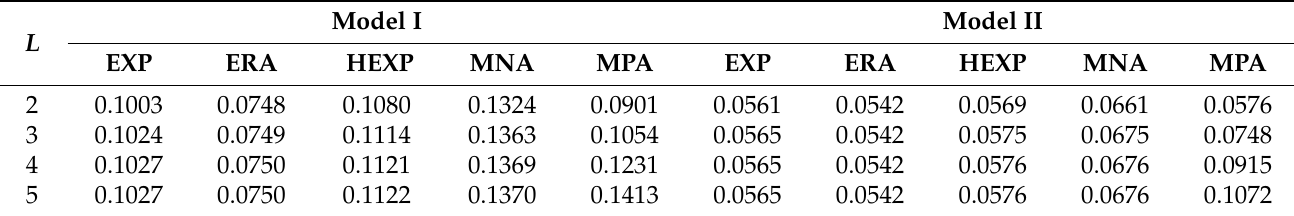
Table 1. Effect of L on expected number of P 1 customers in the system (when θ = 0.6).